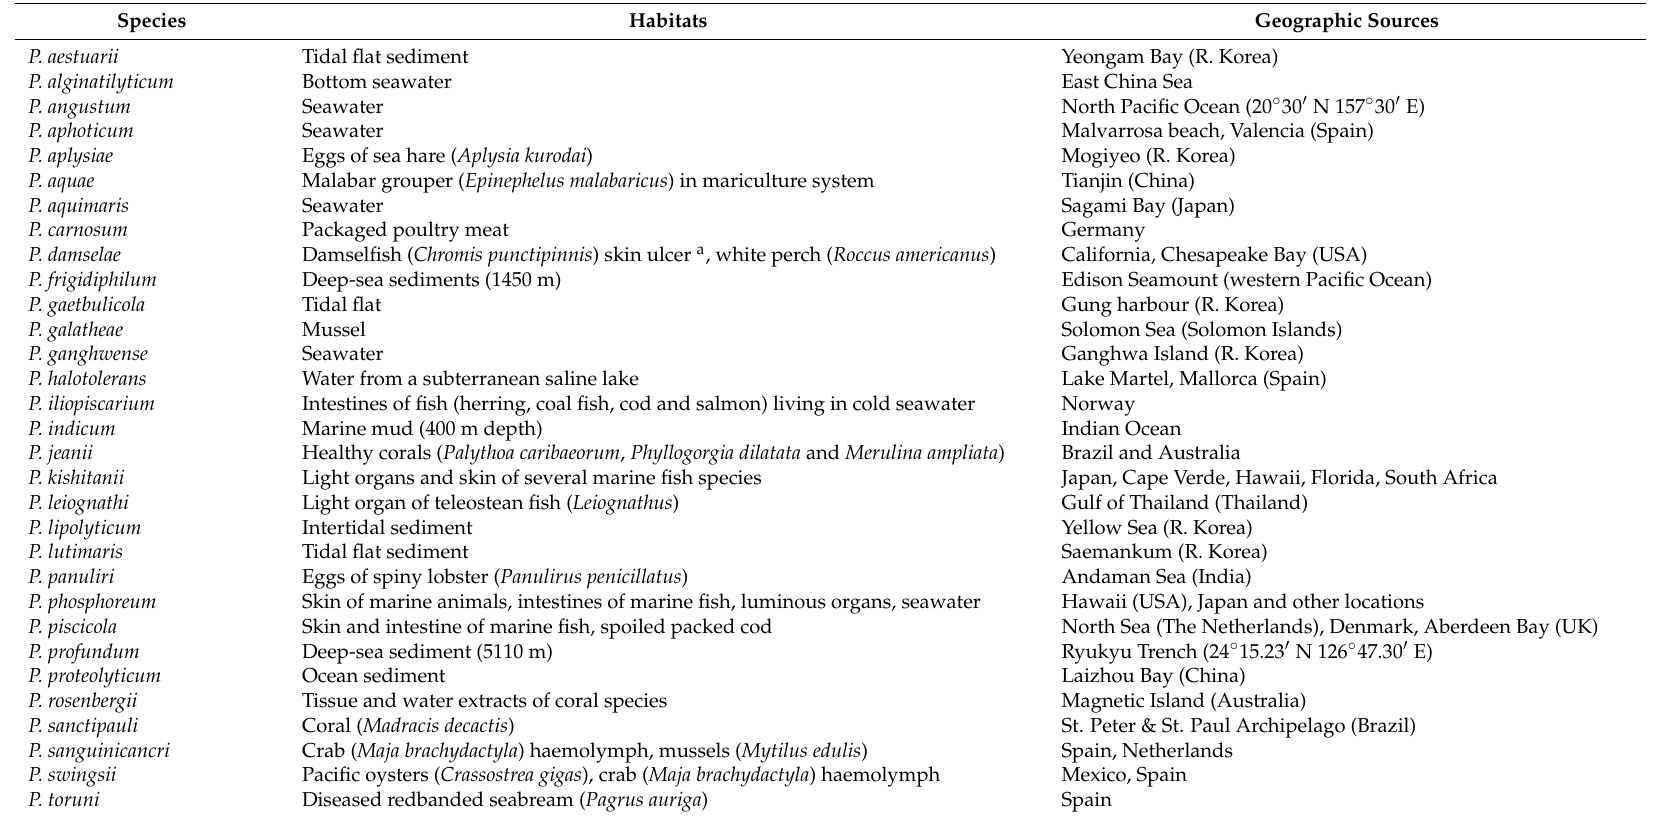
Table 1. List of Photobacterium species including the habitats and geographic sources of